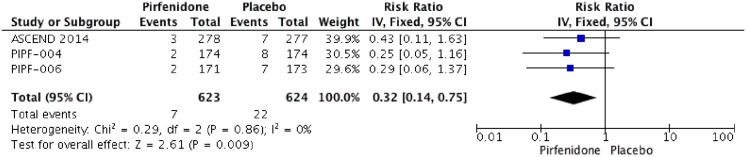
Comparison 2.Idiopathic pulmonary fibrosis (IPF) related mortality at week 52.